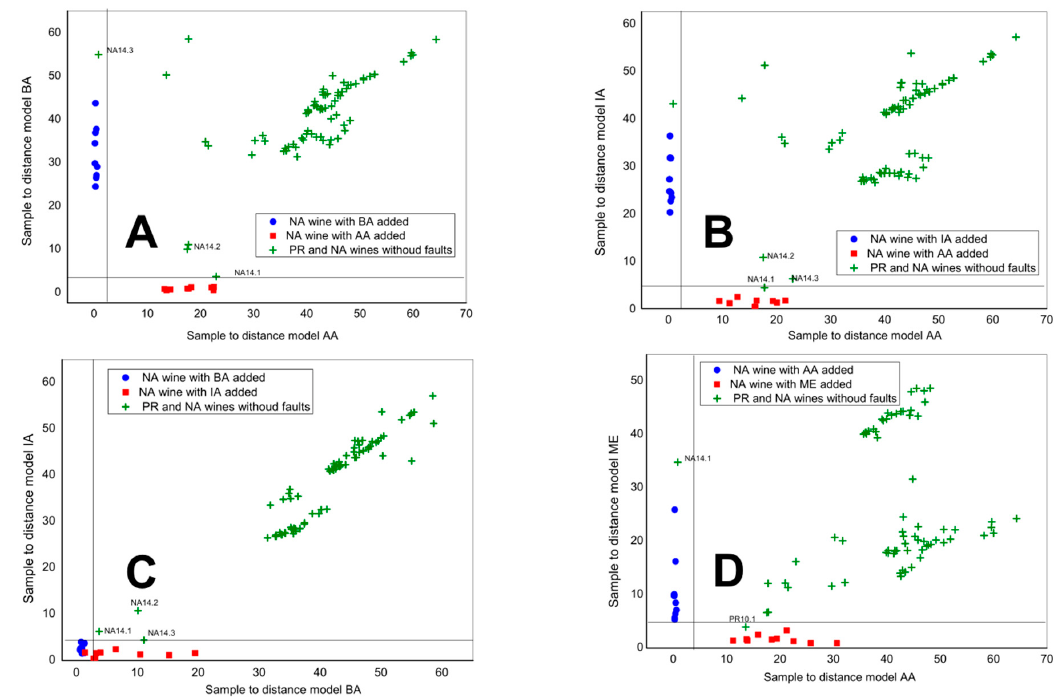
Figure 7. SIMCA classification Coomans plot of Apulian wines (green points) in respect to adulterations: ( A ) BA (blue points) and AA (red points); ( B ) IA (blue points) and AA (red points); ( C ) BA (blue points) and IA (red points); ( D ) AA (blue points) and ME (red points).